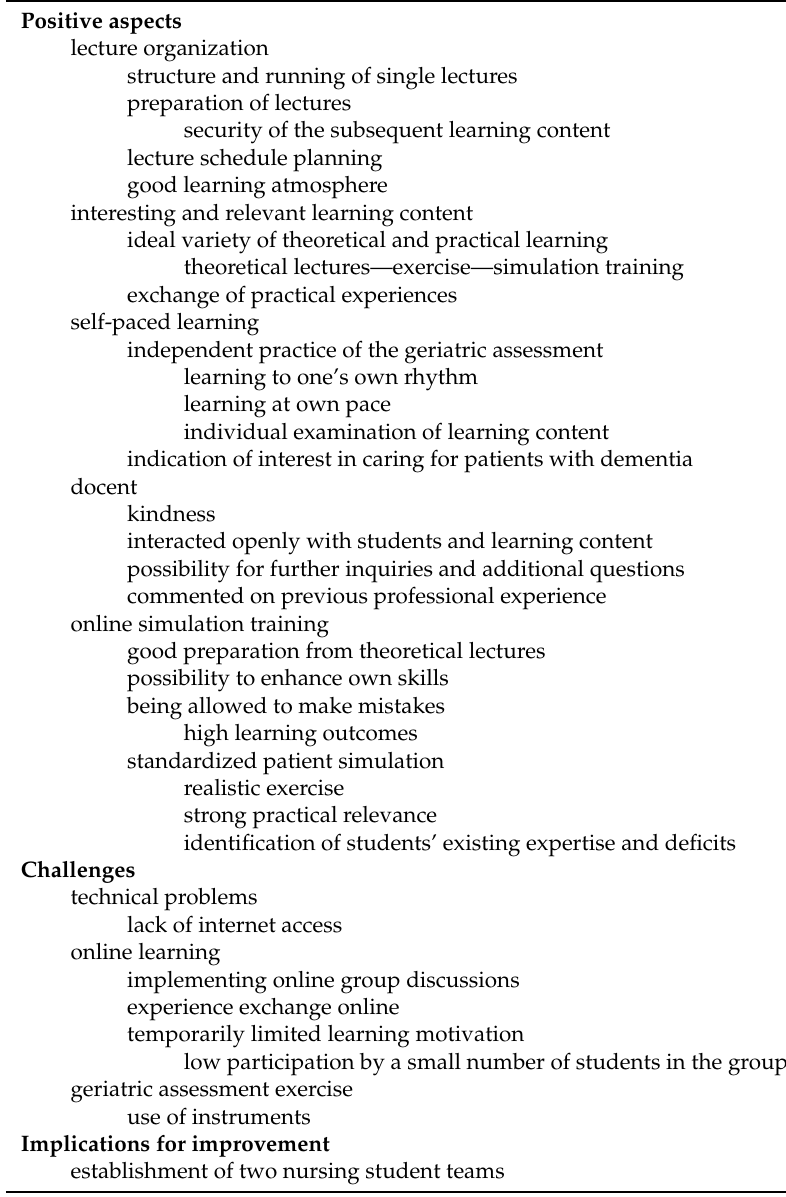
Table 5. Qualitative evaluation results—category